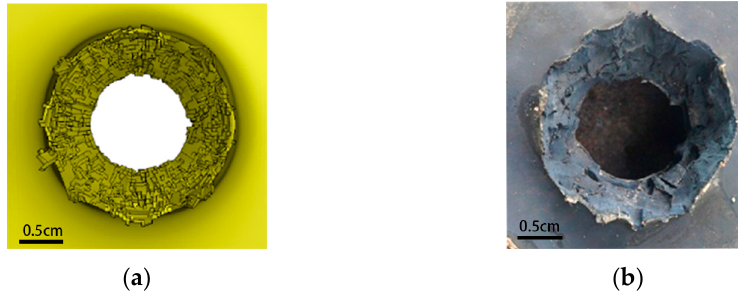
Figure 10. Bullet hole shape: ( a ) numerical simulation and ( b ) test result.